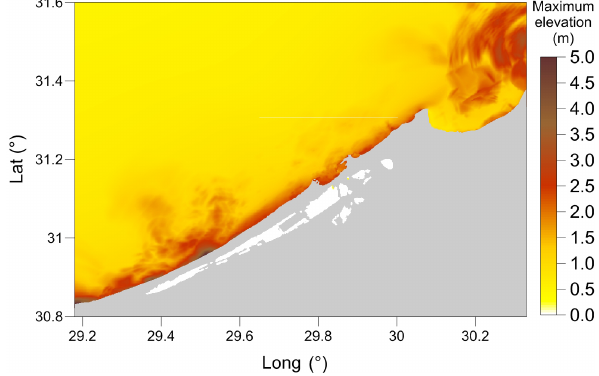
Figure 4. Sea surface maxima for the WHA source, zoomed in on the area of Alexandria with grid 3 (200m